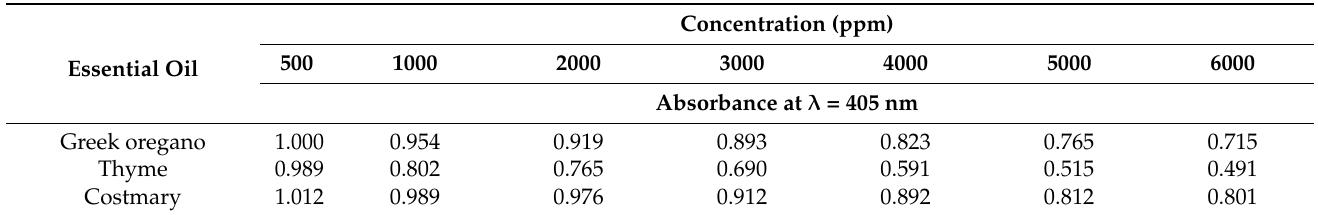
Table 3. Results of DAS-ELISA for the Ch. quinoa plants inoculated with the CMV-S21 isolate with the addition of the EOs.